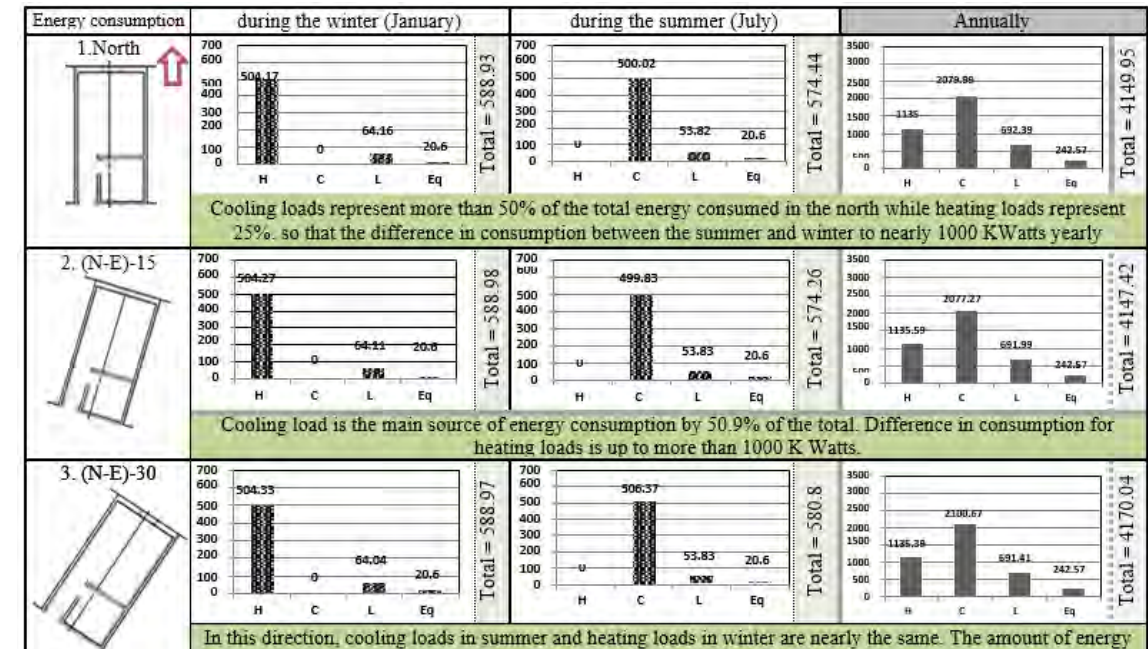
Table 3: Analysis of energy consumption in the directions (north + northeast) annually and during the summer and